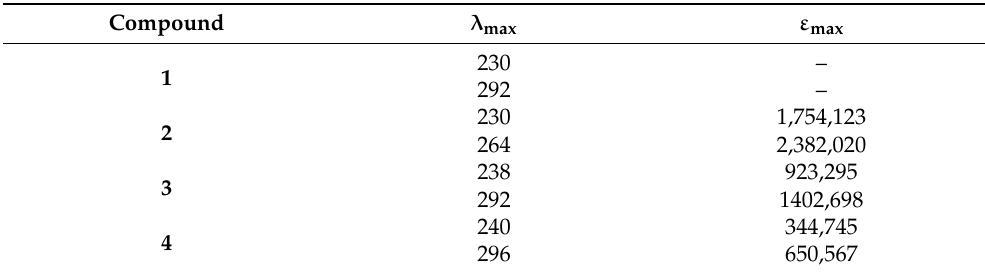
Table 1. Absorption in nm ( λ max , π → π *) and the respective molar absorptivity ( ε max , dm 3 .mol − 1 .cm − 1 ) values of compounds 1 – 4 . Compound λ max ε